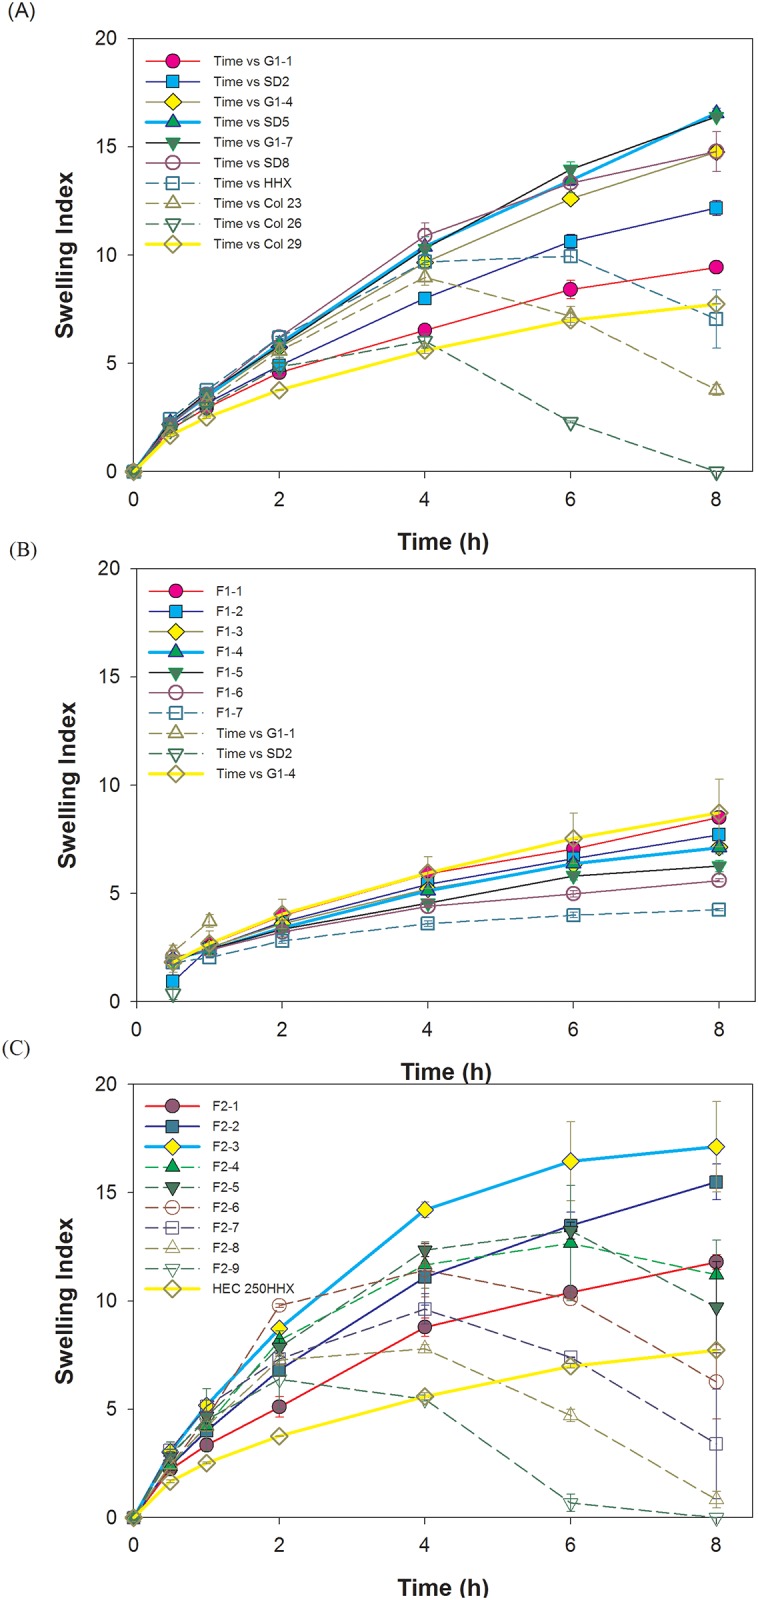
Swelling indexes of the combination of HEC 250HHX and NaCMC of 450 cps in deionized water (A) or in simulated gastric solution (B).Swelling indexes of the combination of HEC 250HHX and NaCMC of 2500 cps in deionized water (C). Representative photographs of the swollen tablets F1–1 and F1–4, after swelling under static conditions in deionized water (D).